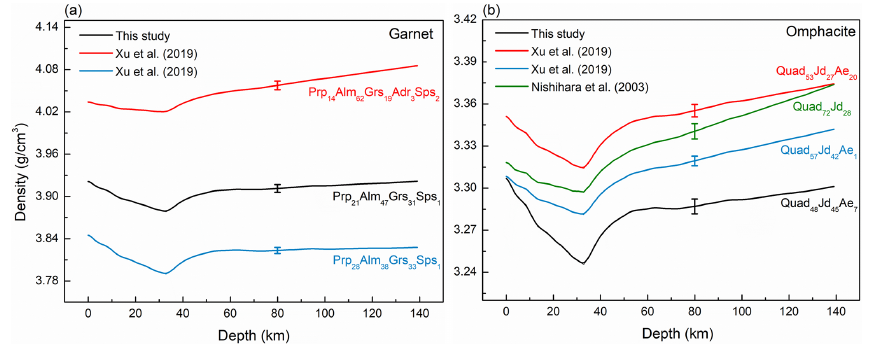
Figure 4. Density profiles of garnet (a) and omphacite (b) along with the cold Tibetan geothermal line (Wang et al., 2013). The garnets of Prp 21 Alm 47 Grs 31 Sps 1 and Prp 28 Alm 38 Grs 33 Sps 1 are from Xu et al. (2019). The omphacites of Quad 53 Jd 27 Ae 20 and Quad 57 Jd 42 Ae 1 are from Xu et al. (2019), and Quad 72 Jd 28 is from Nishihara et al.